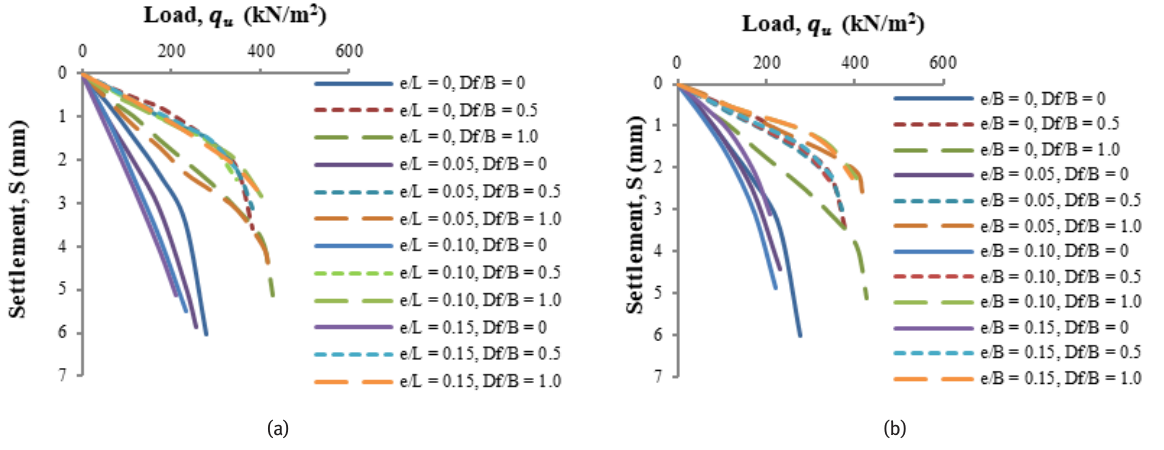
(a) (b) Figure 6: (a) Variation of L–S curve for eccentric loading with an embedment depth D dimension ( e/B )